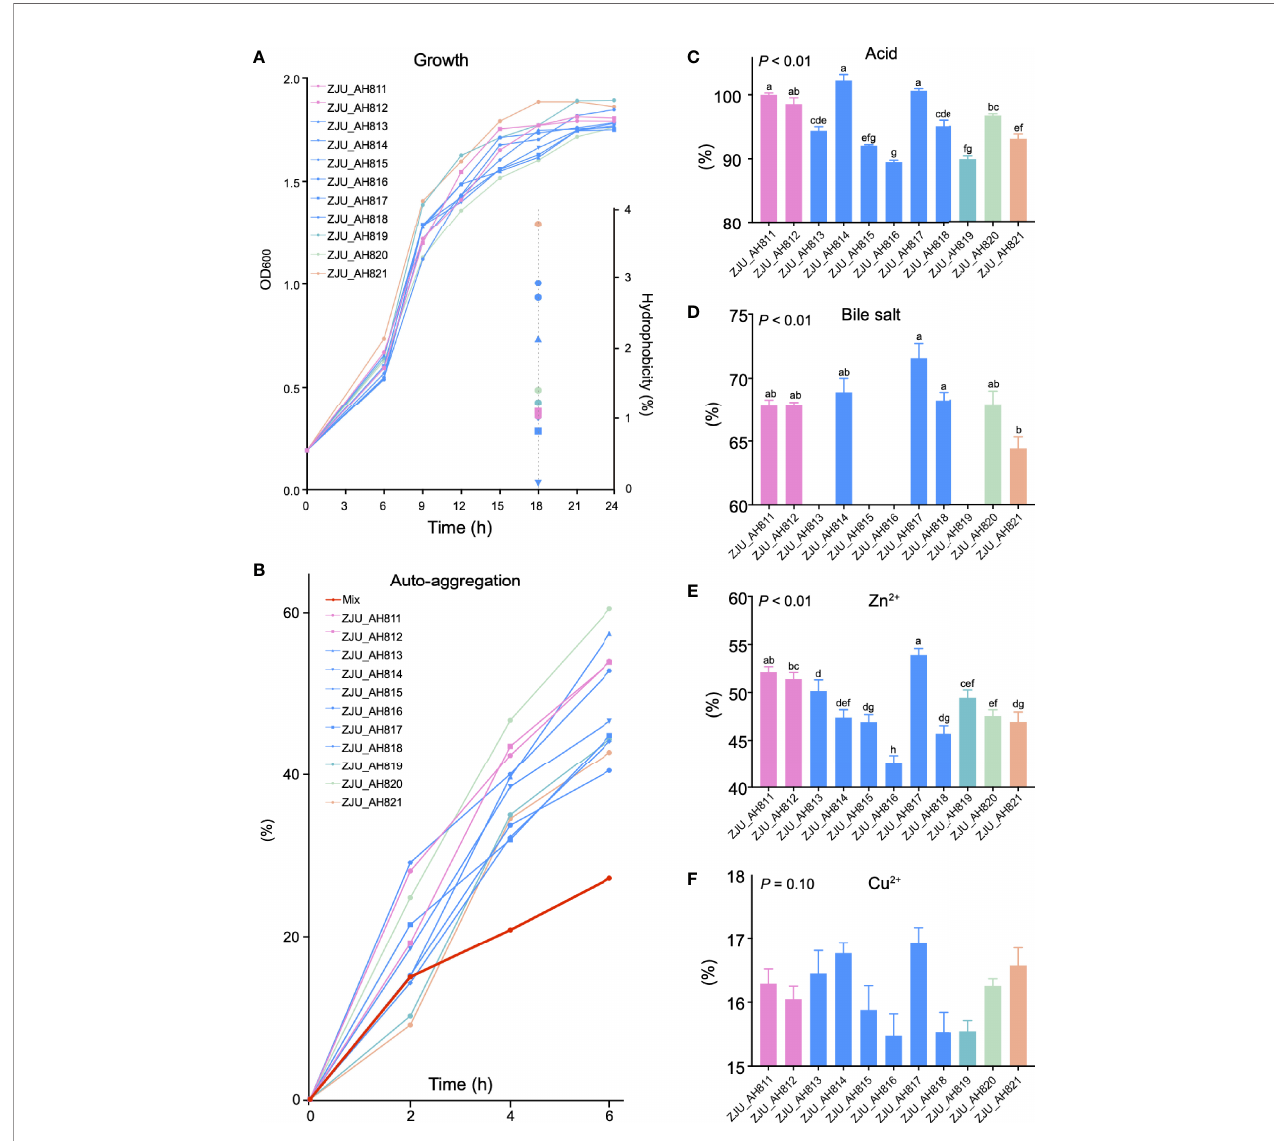
FIGURE 2 | Characteristics of LAB strains. Growth curve and hydrophobicity (A) , and auto-aggregation (B) of single and mixed of 11 LAB strains. Tolerance of (C) acid, (D) bile acid, (E) Zn 2+ , and (F) Cu 2+ of 11 LAB strains (ZJU_AH811, ZJU_AH812, ZJU_AH813, ZJU_AH814, ZJU_AH815, ZJU_AH816, ZJU_AH817, ZJU_AH818, ZJU_AH819, ZJU_AH820, ZJU_AH821). Results are expressed as mean ± standard error of the mean (SEM). Letters a-h in the same graphic were signi fi cantly different (p <